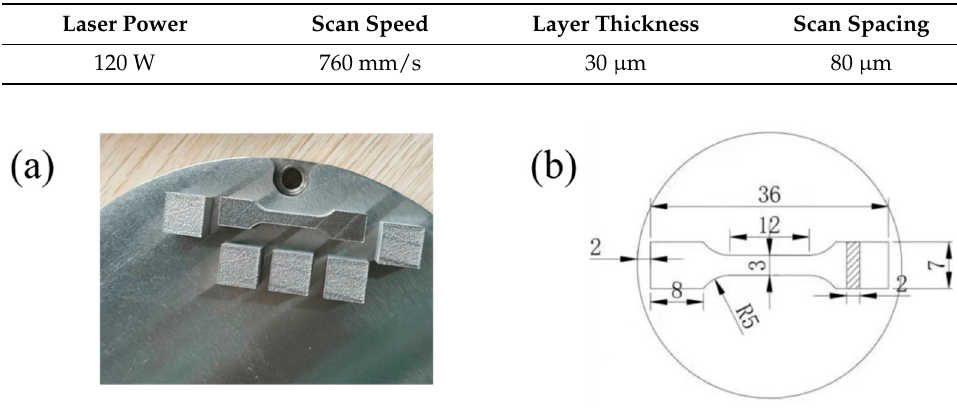
Figure 3. ( a ) LPBF-processed samples; ( b ) outline drawing of tensile